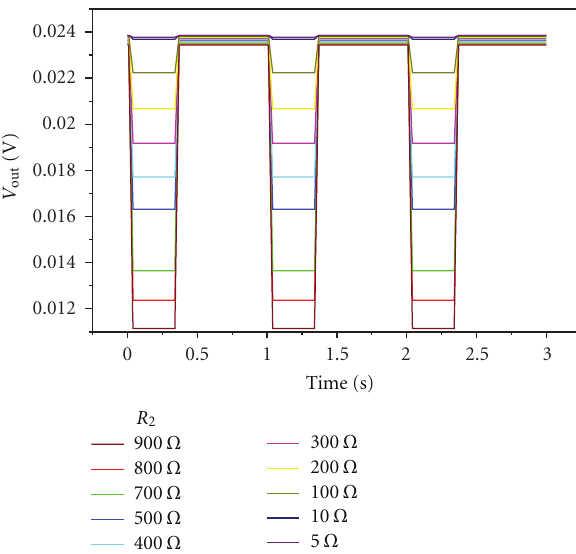
Figure 12: Output voltage levels for the pulse parameter for a change of the resistance of R 2 (5 ( Ω ) ∼ 900 ( Ω